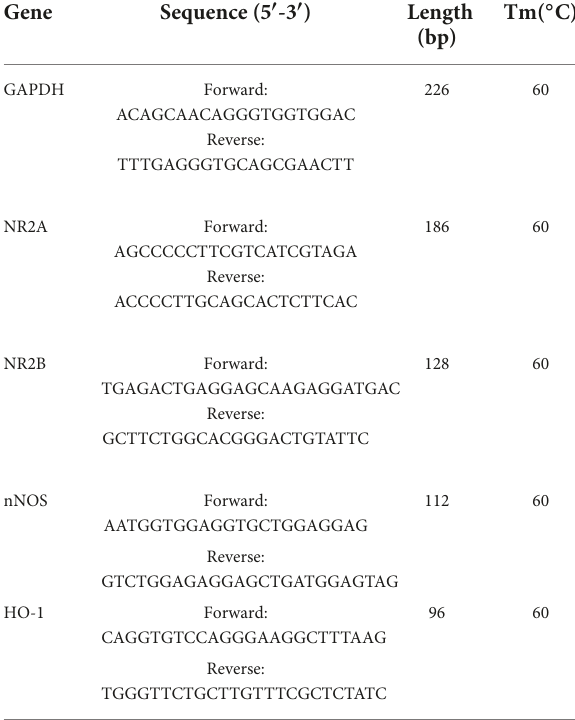
TABLE 1 Primer sequences for qRT-PCR